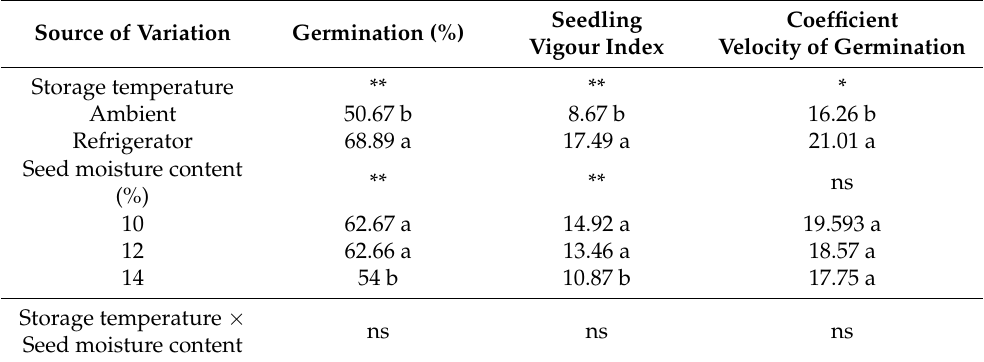
Table 3. Lablab bean seedling germination, vigour, and germination speed after six months of storage under two different storage temperatures.